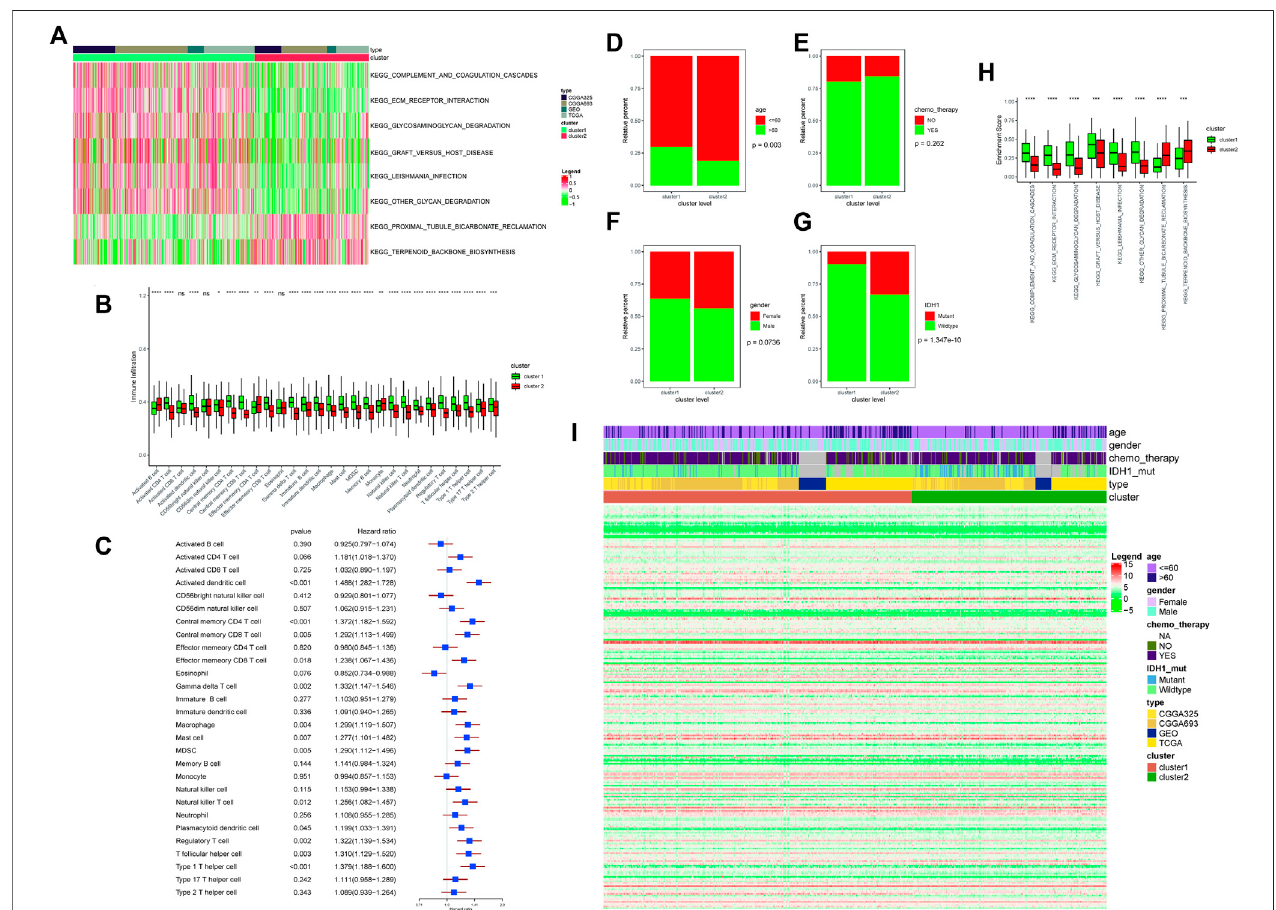
FIGURE 2 | (A) Enrichment score results of differential enrichment items between the two subtypes. Legend column: different colors represent different scores; cluster column: green represents cluster 1, and red represents cluster 2; type column: different colors represent the names of different databases. (B) Differences in immune-in fi ltratingcellsindifferentferroptosisclusters;theabscissaaxisrepresentsdifferentimmune-in fi ltratingcells;theordinateaxisrepresentsthedegreeofimmune cellin fi ltration.Clustercolumn:greenrepresentscluster1,andredrepresentscluster2; pppp means p < 0.0001, ppp means p < 0.001, pp means p < 0.01,and p means p < 0.05. (C) Survival risk analysis of immune-in fi ltrating cells. The type of immune-in fi ltrating cells was listed on the left side; the HR and the forest plot corresponding to immune-in fi ltrating cells were listed on the right side. (D) Correlation analyses between ferroptosis clusters and clinical characteristics: the distribution of different age patients in cluster 1 and cluster 2. The abscissa axis represents different cluster levels; the ordinate axis represents relative percent. Age column: red means age ≤ 60; green means age > 60. (E) Correlation analyses between ferroptosis clusters and clinical characteristics: the distribution of patients receiving chemotherapy in cluster 1 and cluster 2. The abscissa axis represents different cluster levels; the ordinate axis represents relative percent. Chemotherapy column: red represents no chemotherapy, and green represents chemotherapy. (F) Correlation analyses between ferroptosis clusters and clinical characteristics: the distribution of patients ’ gender ratio in cluster 1 and cluster 2. The abscissa axis represents different cluster levels; the ordinate axis represents relative percent. Gender column: red represents female,and greenrepresentsmale. (G) Correlationanalysesbetweenferroptosisclustersand clinicalcharacteristics: thedistributionofIDH1mutationstatus in cluster1 and cluster 2. The abscissa axis represents different cluster levels; the ordinate axis represents relative percent. IDH1 column: red represents mutant status, and green represents wild type. (H) Correlation analyses between ferroptosis clusters and clinical characteristics: the distribution of differential enrichment pathway scores in the two subtypes. The abscissa axis represents different signal pathways; the ordinate axis represents enrichment scores. Cluster column: green represents cluster 1, and red represents cluster 2. (I) Display of ferroptosis-related genes in different ferroptosis clusters. Age column: different colors represent different age ranges; gender column: different colors represent different genders; chemotherapy column: different colors represent the status of chemotherapy; IDH1 column: different colors represent IDH1 mutation status; type column: different colors represent different data types; cluster column: different colors represent different clusters.